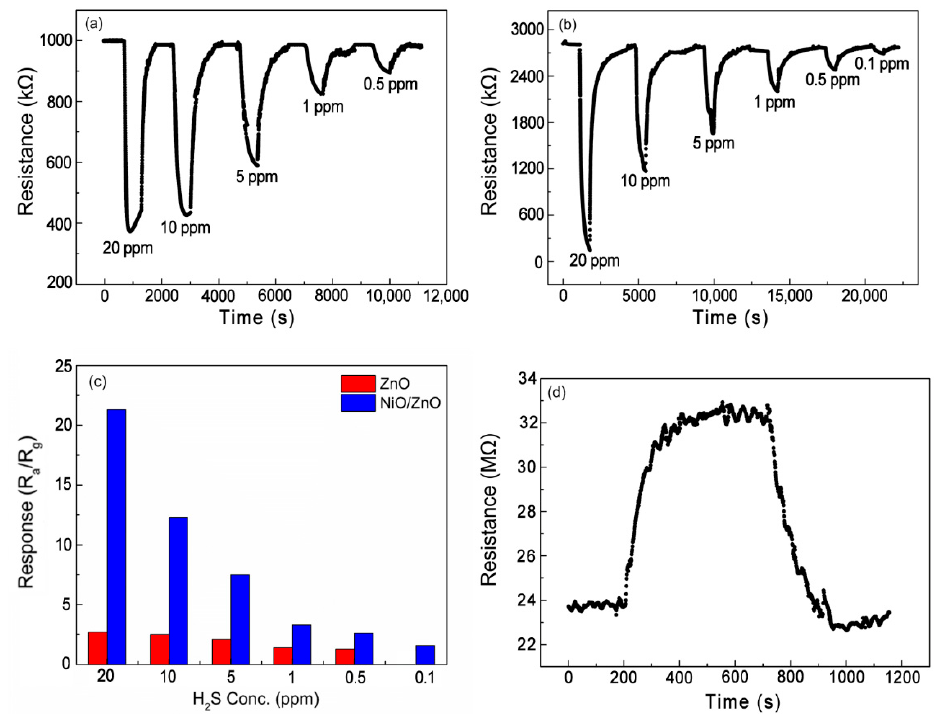
Figure 7. Dynamic response curves upon exposure to H 2 S with di ff erent concentrations at 160 ◦ C exhibited by sensors based on: ( a ) pure ZnO NRs and ( b ) NiO / ZnO, and ( c ) responses histogram of sensors and ( d ) pure NiO NSs.